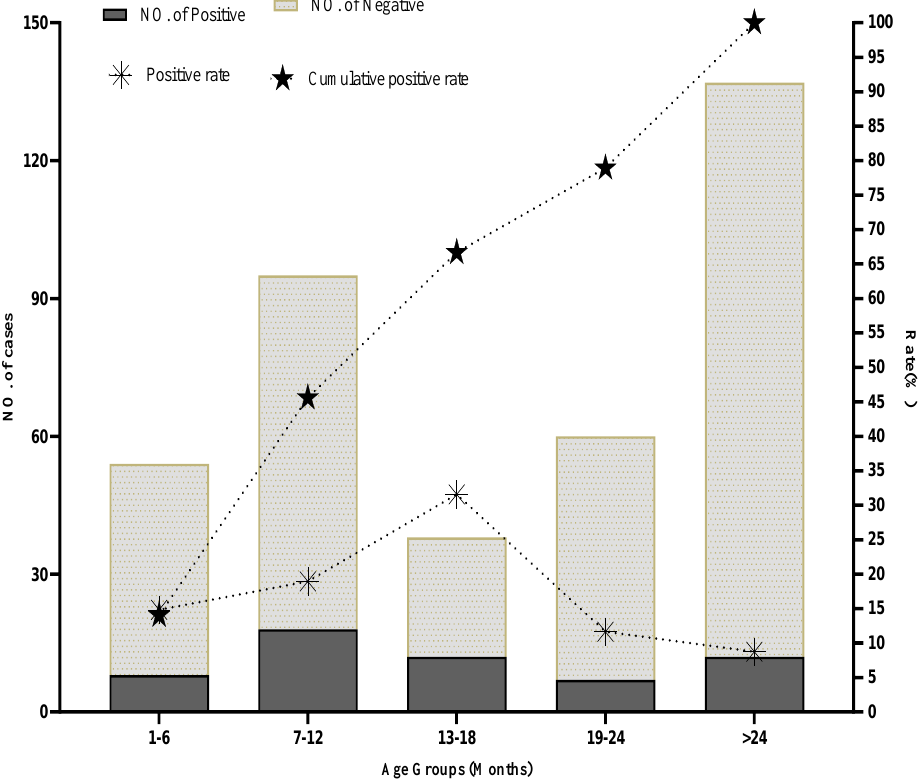
Figure 1. Age group-wise distribution of human adenovirus infection in hospitalized children with gastroenteritis under the age of 5 gastroenteritis under the age of 5 years.